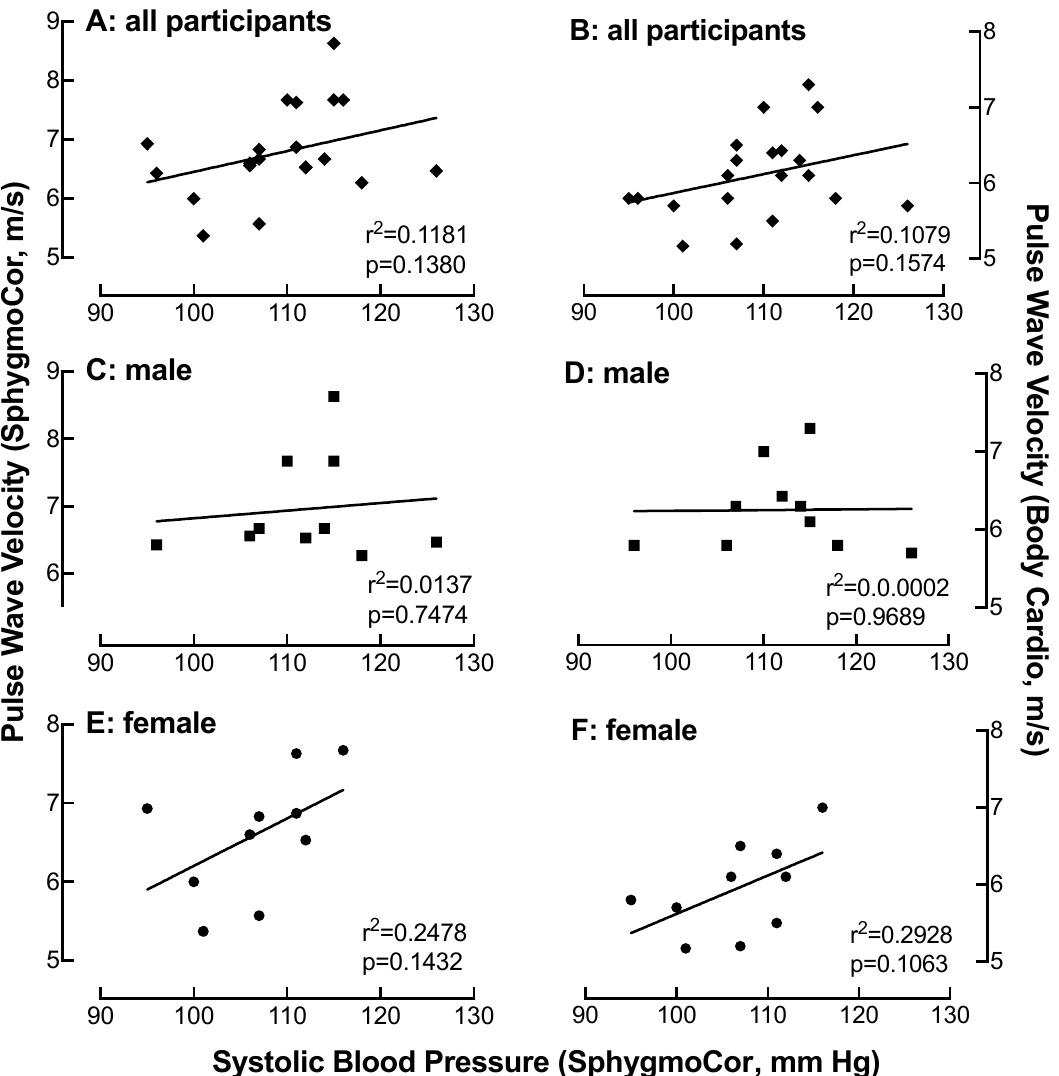
Figure 6. Relationship of systolic blood pressure (SBP) measured on the SphygmoCor with PWV as a function of device. Comparison of SBP with PWV measured on the SphygmoCor ( A , C , E ) or the Body Cardio ( B , D , F ) in all participants ( diamond ) ( A , B ) or specifically in the male ( square ) ( C , D ) or female ( circle ) ( E , F ) population. Each data point represents duplicate or triplicate measures in one study participant. The confidence interval was greater in the women compared to the men (Table 1).